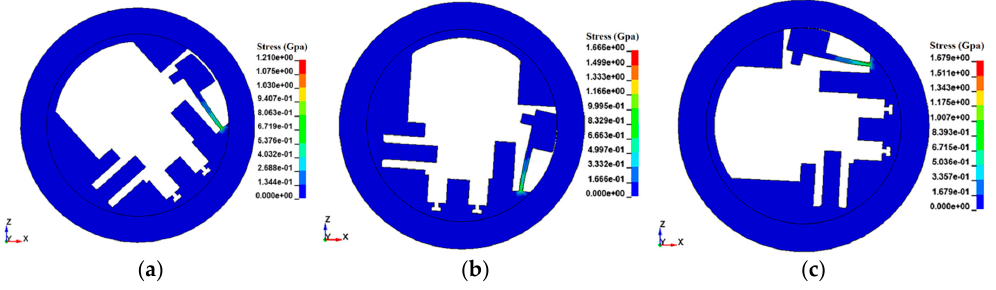
Figure 7. The simulation results of the micro S & A module under different rotary speeds. ( a ) 31,000 rpm; ( b ) 35,000 rpm; ( c ) 45,000 rpm.